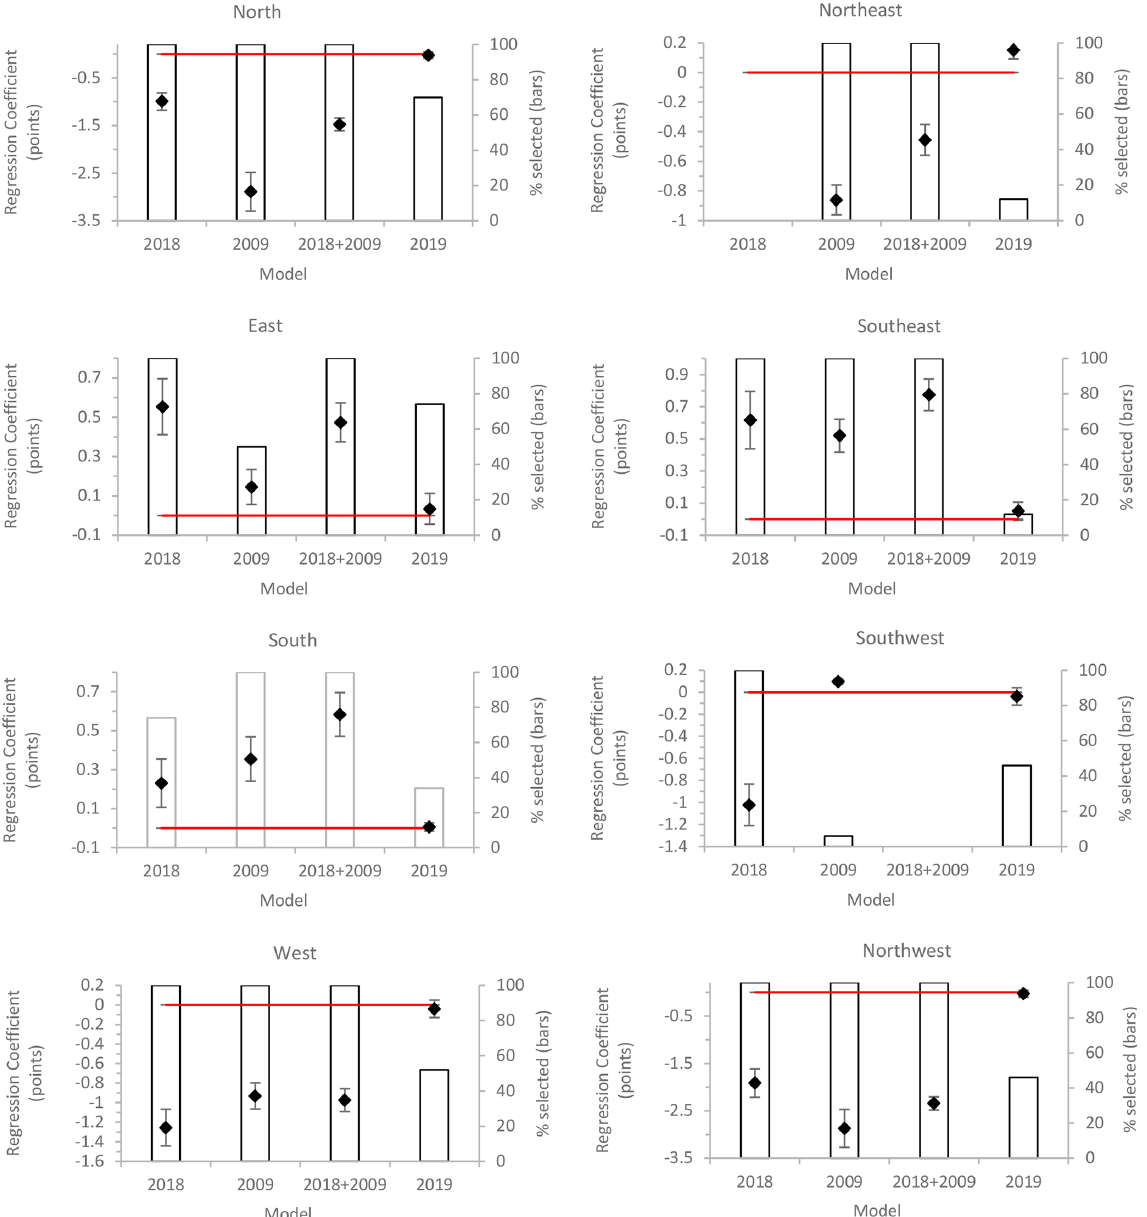
Figure 3. Graphical display of the aspect regression coefficients presented in Table 1. Red line shows the “zero line” for the regression coefficients, black markers show the regression coefficients and associated ± 1 SDs, and the bars show the selection